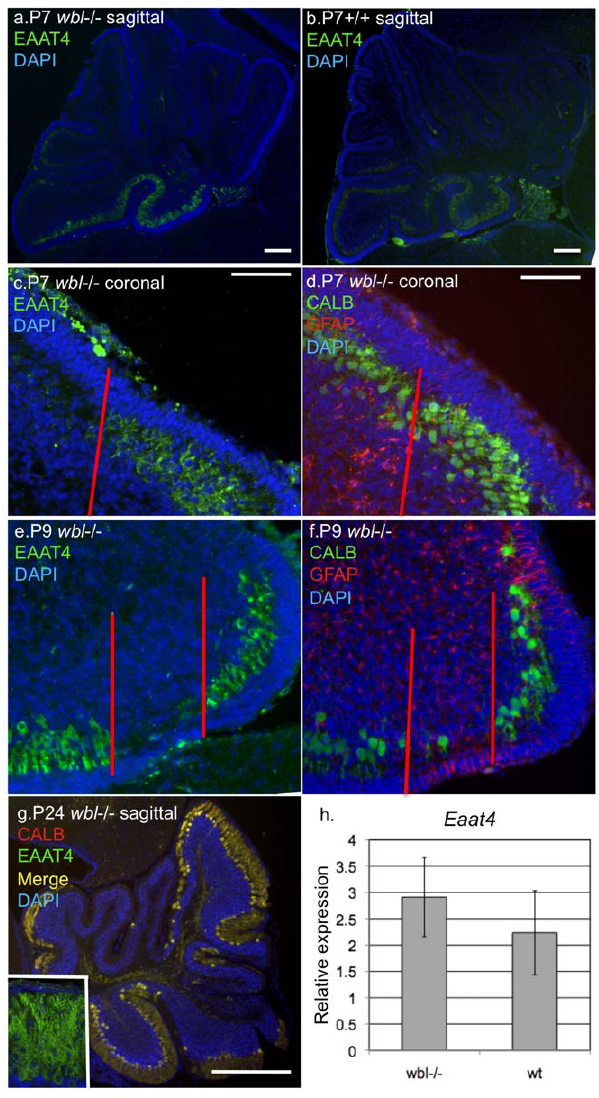
Figure 7. EAAT4 expressing Purkinje cells are protected in early stage Inpp4a wbl mutants. At P7 in midline sagittal sections EAAT4 is restricted to the most caudal lobes in mutant and wild-type (panels a, b). In adjacent coronal sections at P7 a parasagittal stripe of EAAT4 expression is observed, while all Purkinje cells are observed in the neighboring section when stained with calbindin (panels c, d). Reactive gliosis is seen in the EAAT4 negative stripe prior to Purkinje cell loss (panel d left of red line). At P9 most EAAT4 negative Purkinje cells have degenerated leaving a few abnormal Purkinje cells and significant gliosis (panels e, f). At P24 all remaining Purkinje cells are those that express EAAT4 (panel g, inset shows single labeled EAAT4). Quantitative real-time PCR shows that Eaat4 expression is preserved in mutant brains (panel h).